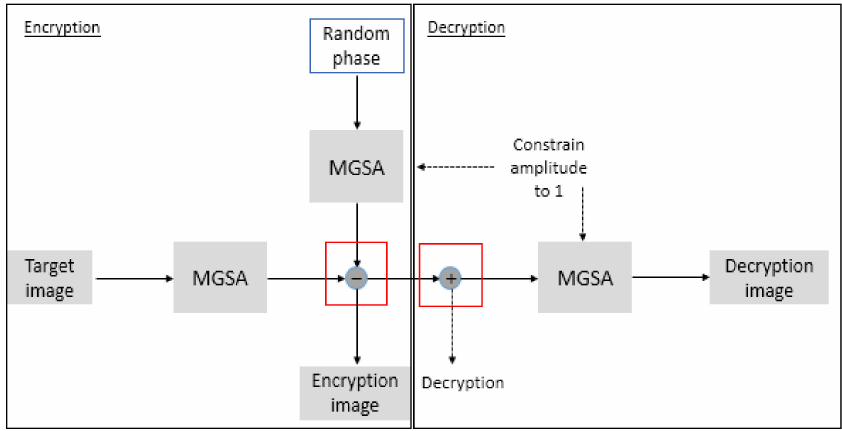
Figure 4. Phase-locked algorithm flow